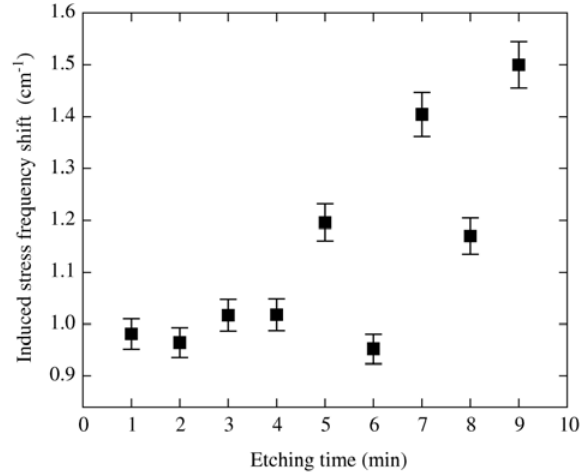
Figure 2. Stress induced shift (squares) as a function of the etch- ing